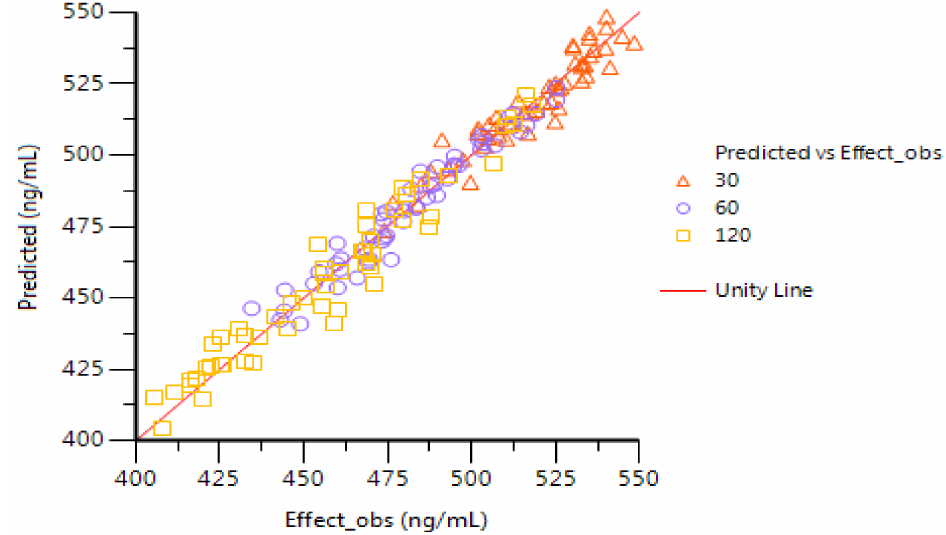
Figure 4. PD prediction and actual value of PGE 2 concentrations in AA rats. Predicted values are shown by solid lines; observations are shown by hollow triangles (GE, 30 mg/kg), open circles (GE, 60 mg/kg) and hollow quadrilaterals (GE, 120